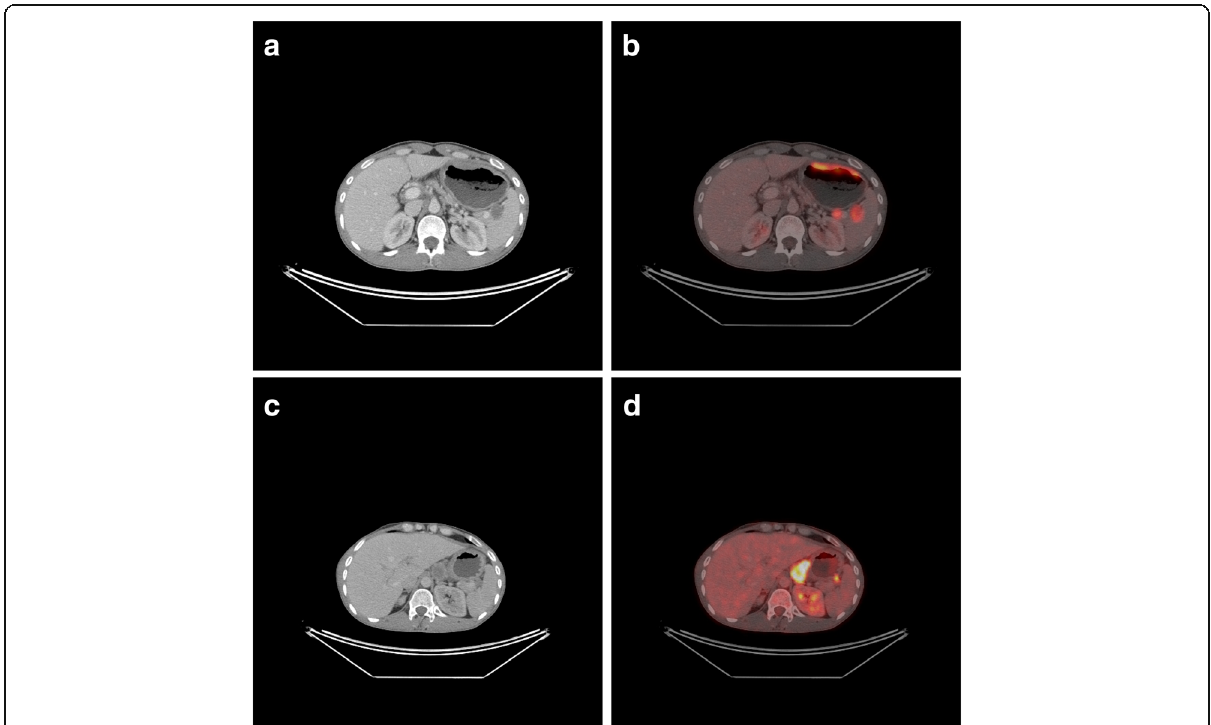
Fig. 2 A 29-year-old male, known case of gastric antrum and body B cell lymphoma, received CTH, the last session 2 weeks ago with irrelevant surgical history. a , b His initial PET/CT compared to his interment study revealed splenic hilar lymph node measuring 16 × 19 mm with SUV 9.6. c , d His interment study revealed no size change compared to the previous study yet reduced SUV max to be 8.9. This case was stationary by CT while regressive by